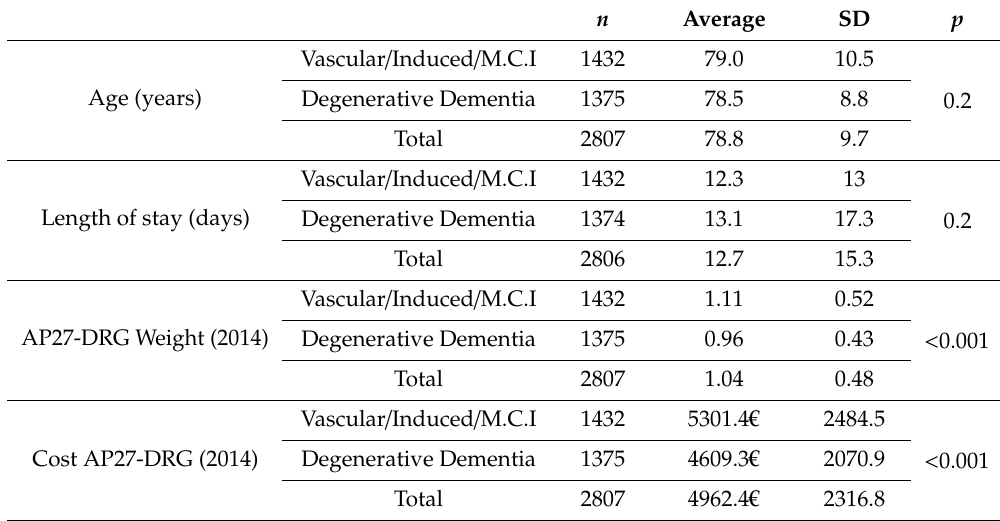
Table 2. Healthcare and economic assessment of the sample.